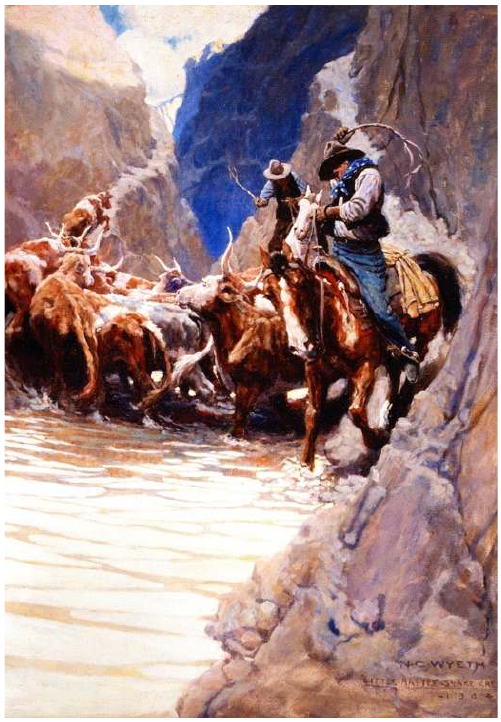
Figure 4. N. C. Wyeth, Rounding Up. Oil on canvas